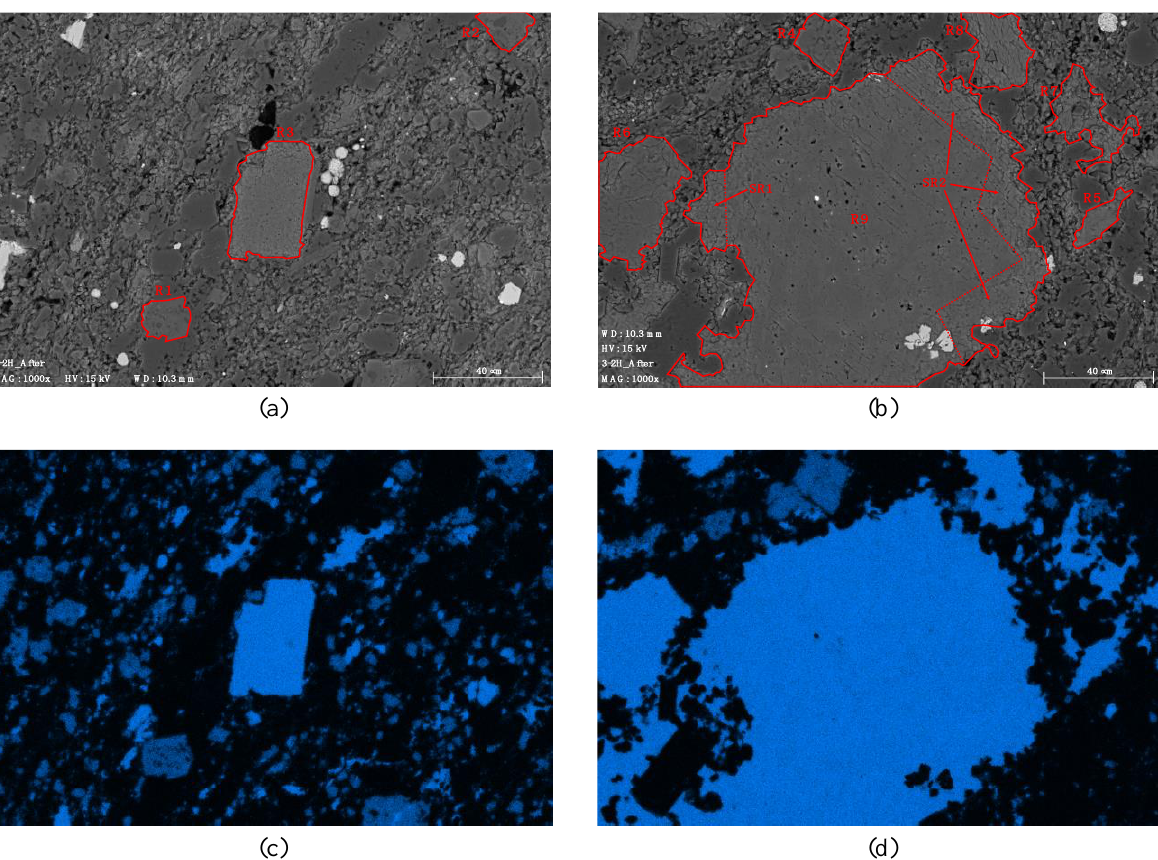
Figure 17. BSE images and EDS maps of calcite and dolomite grains at two different regions ( a , b ) BSE images from these two regions with different sizes of calcite/dolomite grains; ( c , d ) the EDS maps of calcium associated with the regions of BSE images.